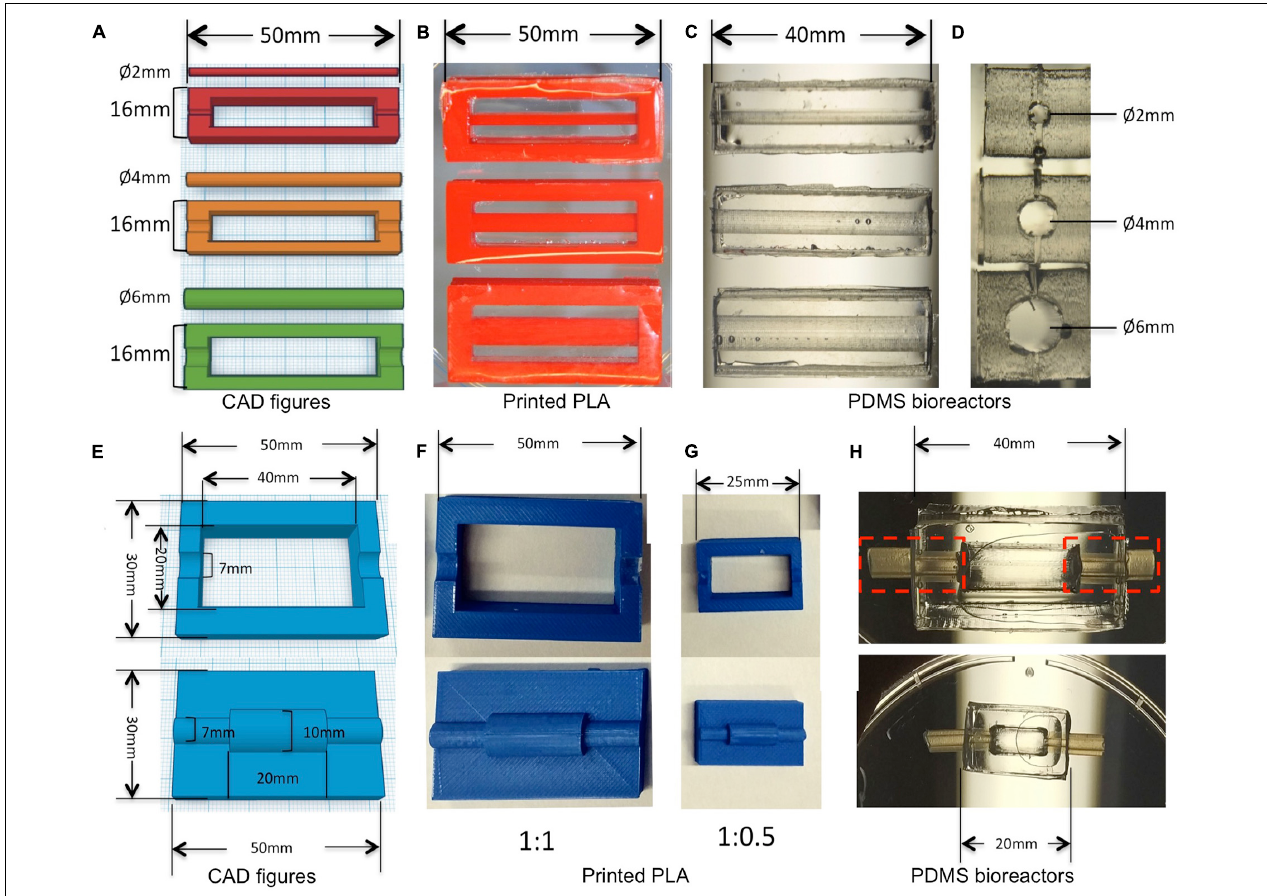
FIGURE 1 | 3D design and printed molds for creating bioreactors for different diameters of vessels. (A) CAD figures of molds for creating PDMS bioreactors with different inner chambers. (B) PLA molds printed with the design in panel (A) . (C,D) PDMS bioreactors with different sizes of inner chambers made from panel (B) . (E) CAD figures of molds for creating PDMS bioreactors with silicone tube connection. (F) PLA molds printed with the design in panel (E) . (G) PLA molds printed with the half size of panel (F) . (H) PDMS bioreactors with different length and diameter of inner chambers made from panels (F,G)